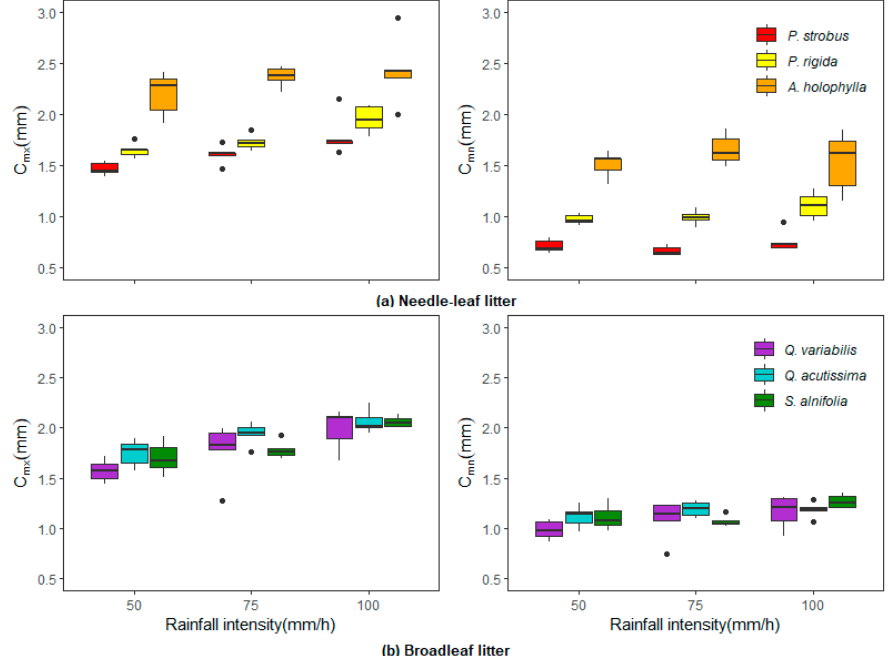
Figure 6. Variations in litter interception storage with rainfall intensity. ( a ) needle-leaf litter, and ( b ) broadleaf